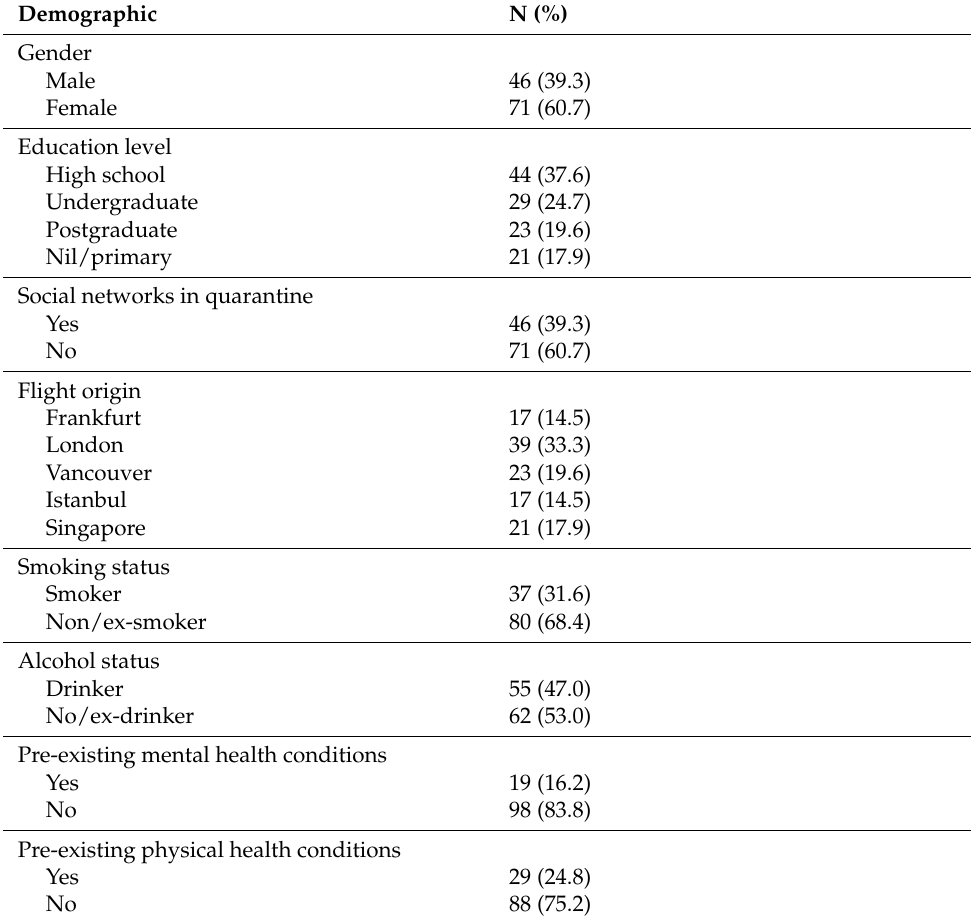
Table 1. The participants’ characteristics.